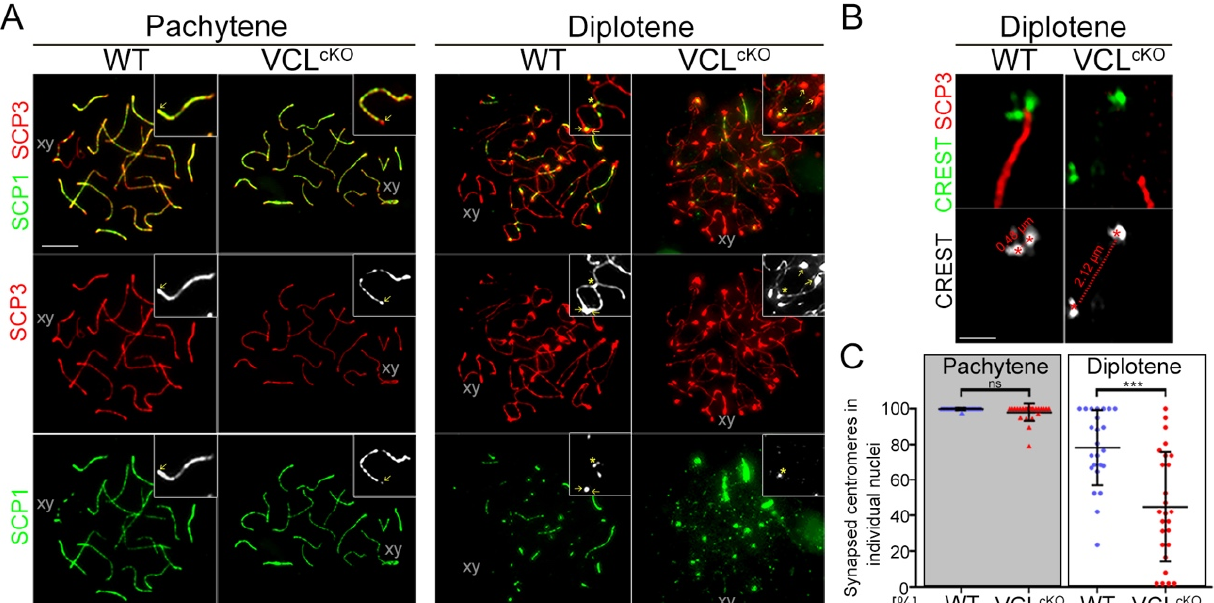
Figure 5. VCL cKO possessed defective synapsis I pachynema and diplonema; ( A ) the patterns of the SCP3 (the axial element) and SCP1 (the central element) of the synaptonemal complex differed between WT and VCL cKO . In VCL cKO pachytene nuclei, an irregular SCP1 signal was apparent along the chromosome axis and mostly missing at the centromere (pachytene VCL cKO , arrow). In diplotene, SCP1 was usually present only at the associated centromeres (diplotene WT, arrows) and the chiasma (diplotene WT, asterisk). In VCLcKO spermatocytes, centromeres lacked SCP1 and were de-synapsed (diplotene VCL cKO , arrows). Strong SCP1 aggregate was found only at the chiasma (diplotene VCL cKO , asterisk). The scale bar represents 5 µ m; ( B ) staining the centromeres with CREST (green) and SCP1 (red) enabled evaluation of de-synapsis in diplotene VCL cKO spermatocytes. Evaluation of the synapsed and de-synapsed centromeres was performed according to the distance between two CREST foci, i.e., ≤ 0.6 µ m is synapsed and >0.6 µ m is de-synapsed. The scale bar represents 1 µ m; ( C ) the graph shows the levels of centromere synapsis in each individual nucleus (20–25 autosomes were analyzed) at the pachytene and diplotene in WT and VCL cKO . p -values represent a comparison of the synapsed groups (Mann–Whitney U-test) for pachytene (ns = 0.0554) and diplotene (*** = 0.0002). Error bars show the mean ± SD. We scored the number of bivalents with synapsed centromeres and present the results in a graph as a percentage of all bivalents. Each value represents one evaluated spermatocyte spread.